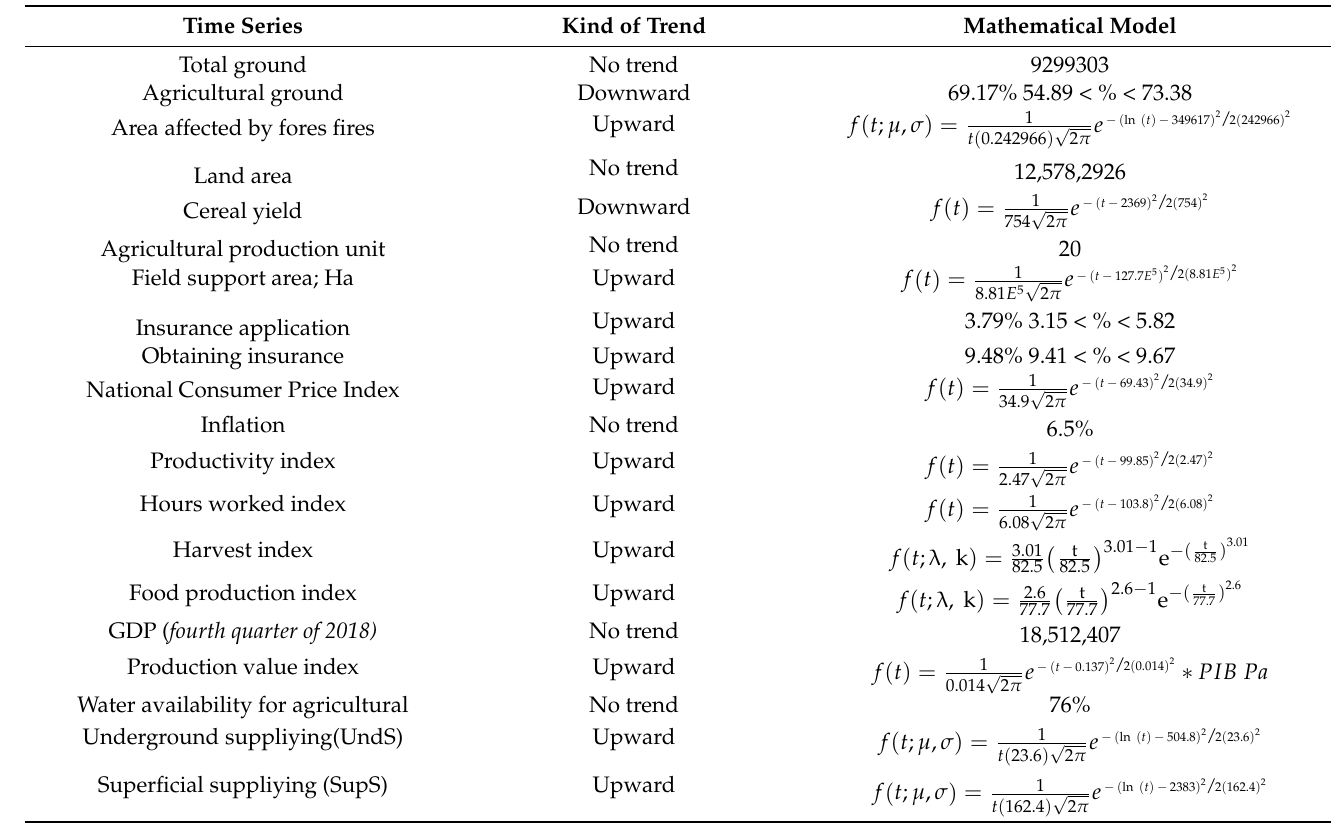
Table 3. Analysis of trend of vulnerability indicators